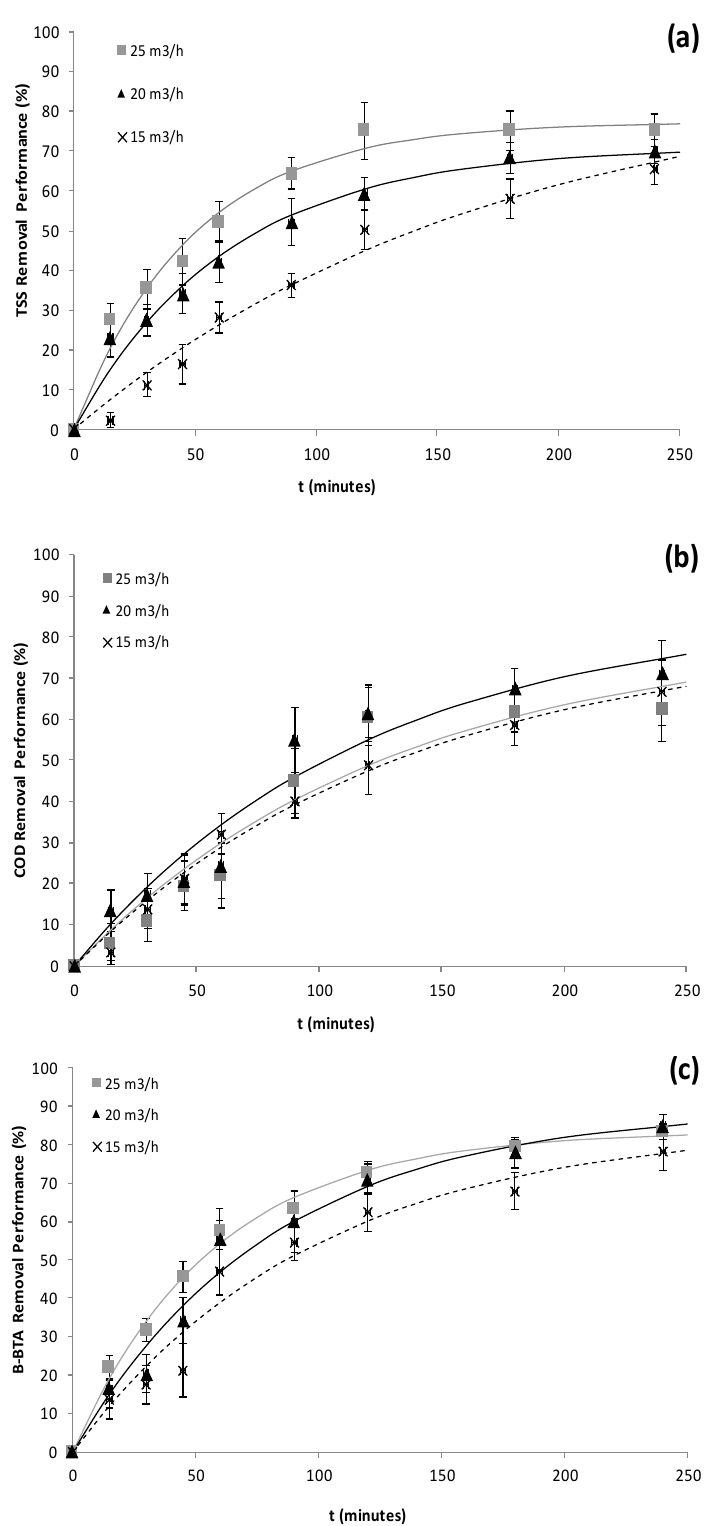
Figure 3. Laboratory study investigating the effect of different O 2 flow rates on the removal of: ( a ) total suspended solids (TSS); ( b ) chemical oxygen demand (COD); and ( c ) benzotriazole based anticorrosive agent (BTA-A). Note: Error bars stand for standard deviation values ( n = 3). Experimental results are shown together with fittings to the pseudo first-order kinetic model (grey continuous line, black continuous line and black discontinuous line represent fittings to removal under 25, 20 and 15 m 3 /h of O 2 , respectively).